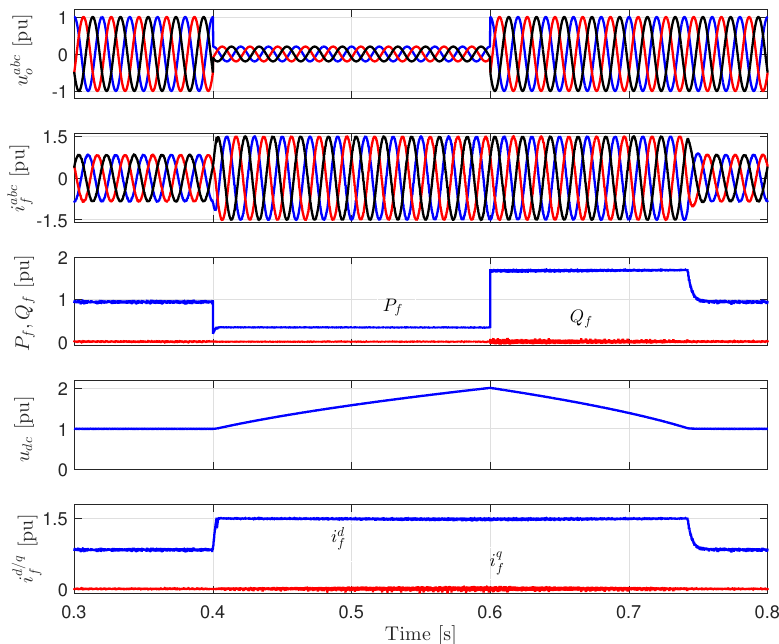
Figure 2. Performance of the GSC and DC-link during a three-phase fault without FRT strategy (from top ): grid voltages u abc o = ( u a o , u b o , u c o ) (cid:62) , GSC output currents i abc reactive power injected to the grid ( P f , Q f ), DC-link voltage u dc , and d - and q -axis currents of the GSC ( i d , i q ). f f